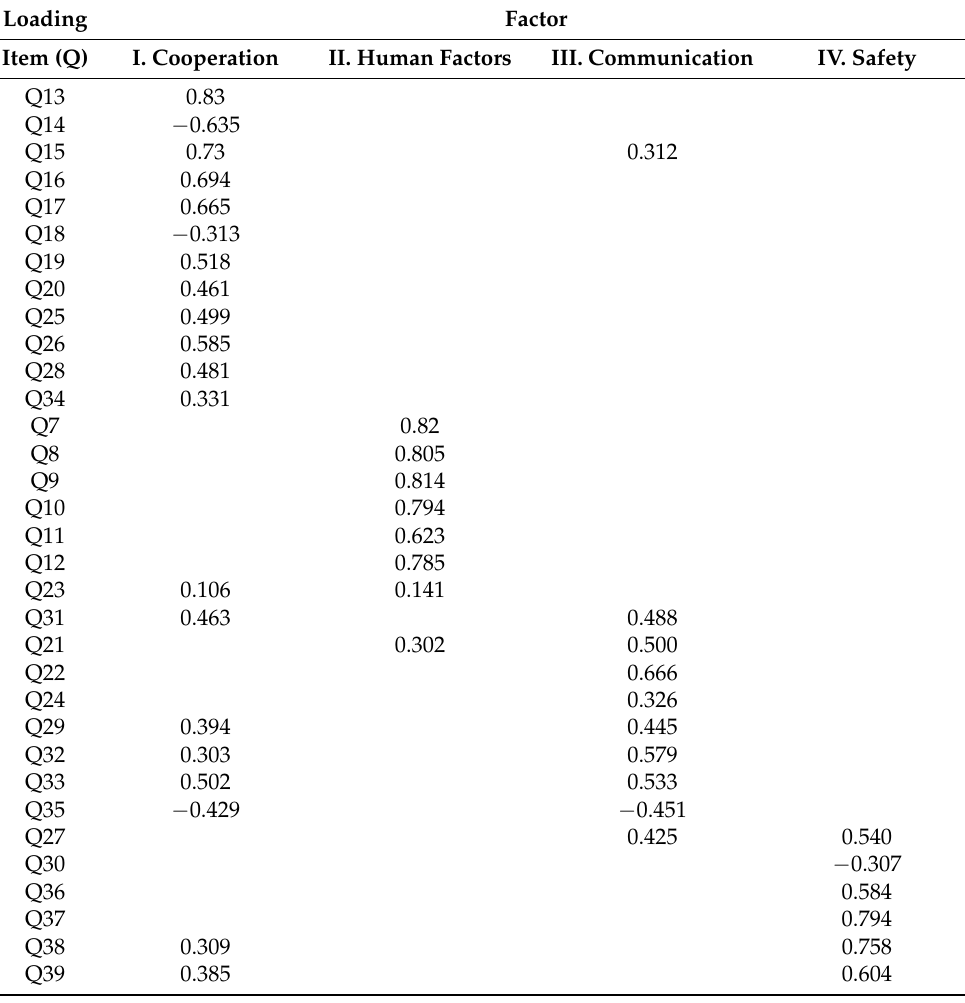
Table 2. Rotated component matrix: representation of the factor